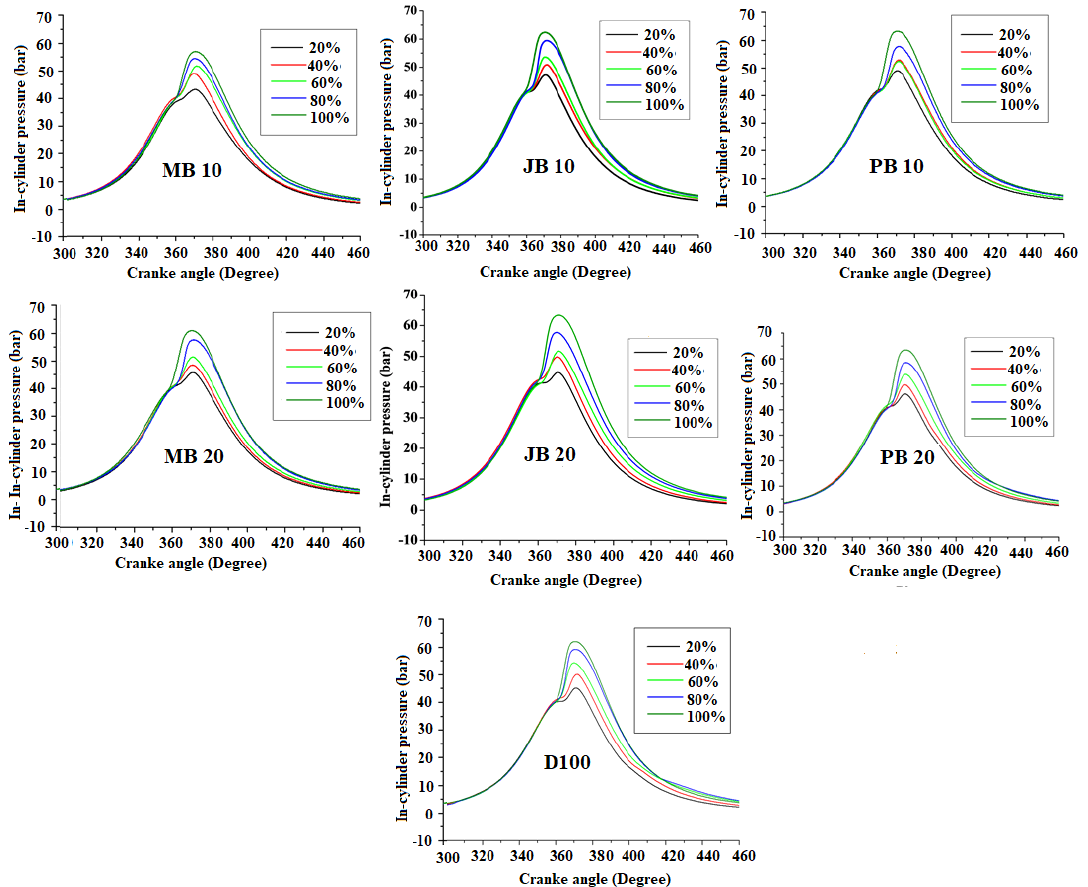
Figure 4. In-cylinder pressure profiles with diesel, microalgae, polanga, and jatropha biodiesel blends at different loads.